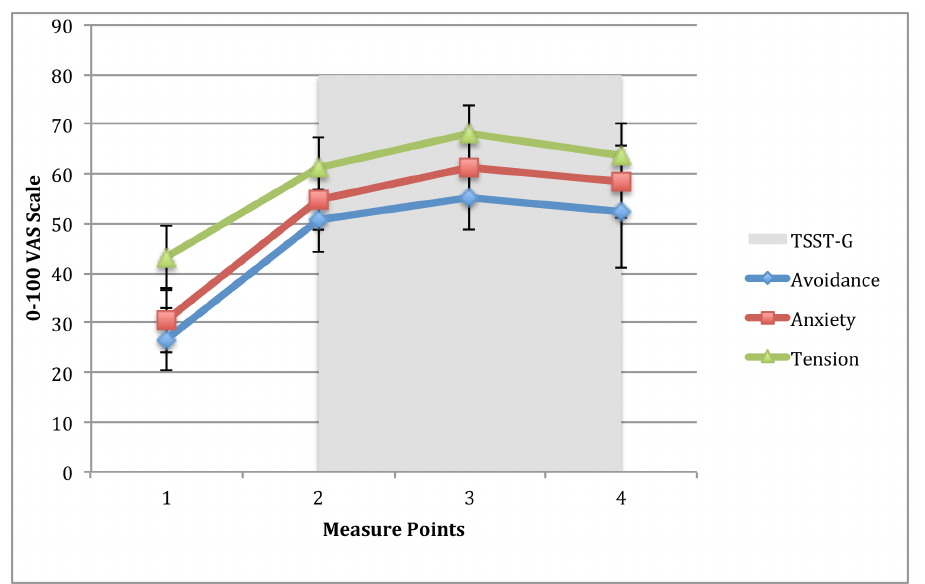
Figure 4. Visual analogue scales (VAS) completed before and during the TSST-G. The scales ranged from 0–100, and participants were told that 0 was no feeling of discomfort and 100 represented the worst feeling of avoidance: ‘‘To what extent do you want to leave this setting?’’ Anxiety: ‘‘To what extent do you feel uncomfortable in this setting?’’ And tension: ‘‘To what extent do you feel tension in your body right now?’’ Error bars represent 95% confidence